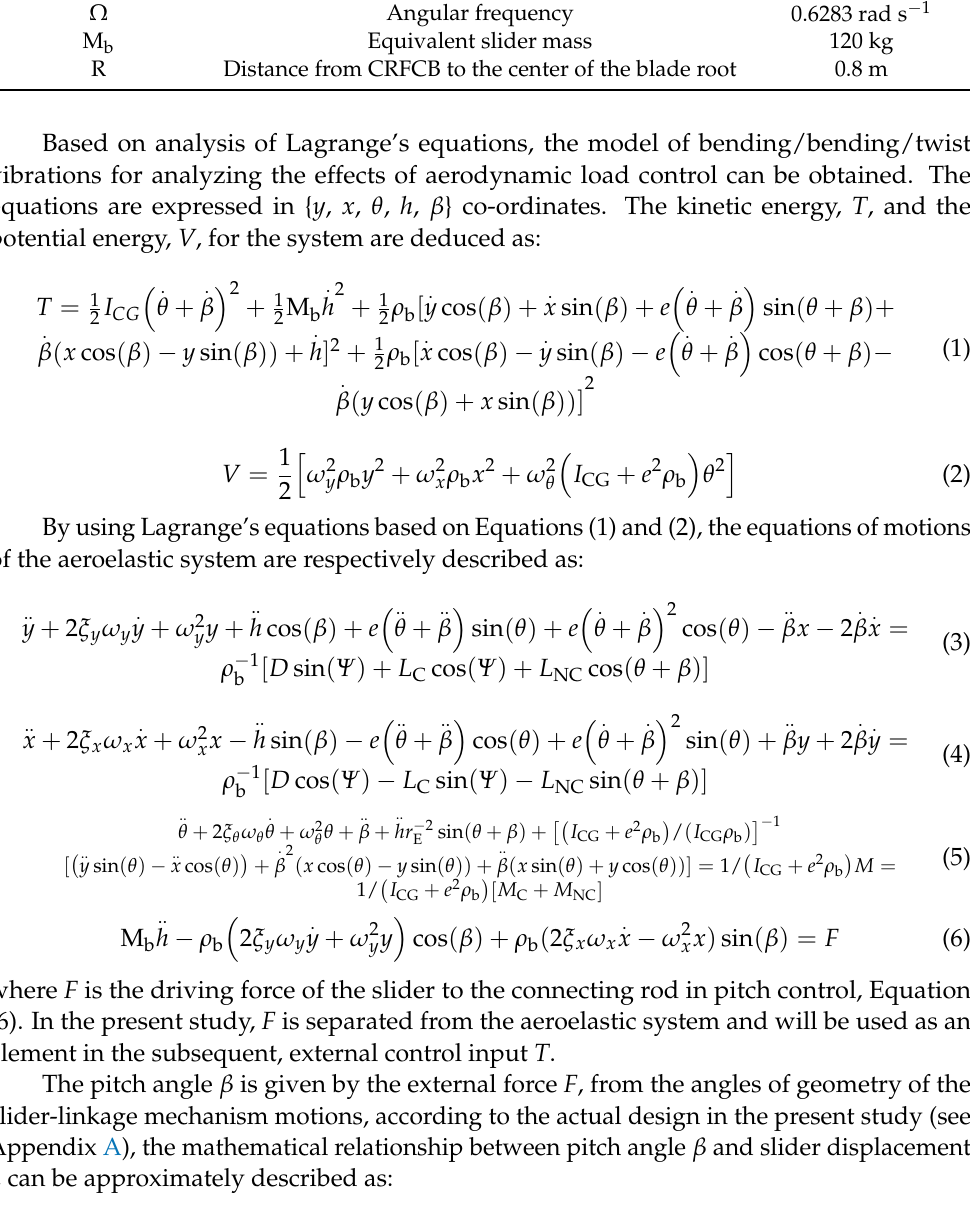
Table 1. The blade sectional parameters and related parameters. Symbol Quantity Values ω x Angular frequency 18 rad s − 1 ω y Angular frequency 12 rad s − 1 ω θ Angular frequency 5 π rad s − 1 ρ b Mass per length of blade 50 kg m − 1 I CG Rotational inertia 10 m kg U Wind speed 5 m s − 1 a The sum of the lengths of the two connecting rods 2 m ξ x Damping ratio 0.08 ξ y Damping ratio 0.06 ξ θ Damping ratio 0.06 e Distance between the two centers 0.1 m Ω Angular frequency 0.6283 rad s − 1 M b Equivalent slider mass 120 kg R Distance from CRFCB to the center of the blade root 0.8